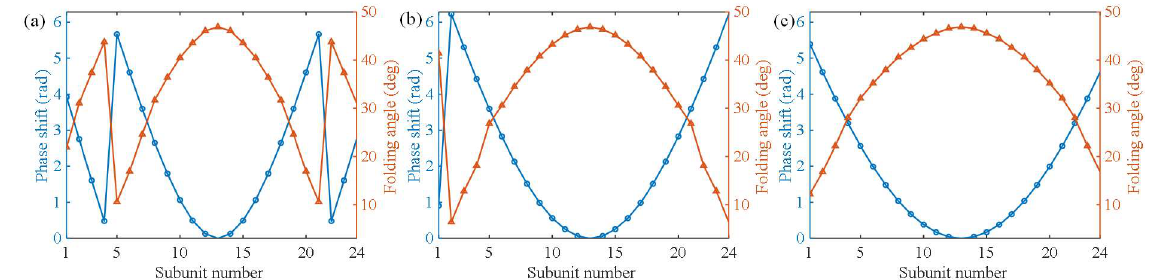
Figure 7. Distribution of the phase shift obtained from the GSL and the distribution of the folding angle obtained from the numerical simulations when the focal distance is ( a ) λ , ( b ) 2 λ and ( c ) 3 λ .